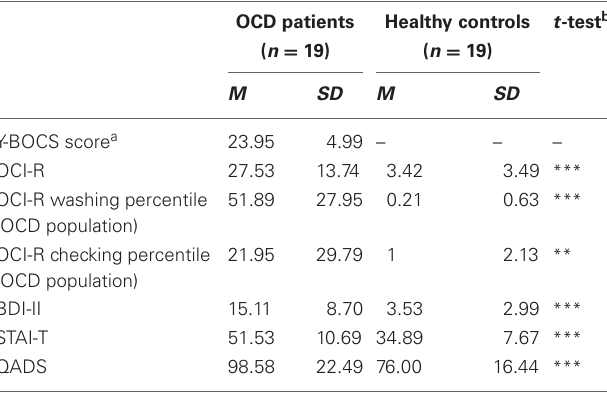
Table 2 | Overview and test statistics for central clinical data for OCD patients and healthy controls.